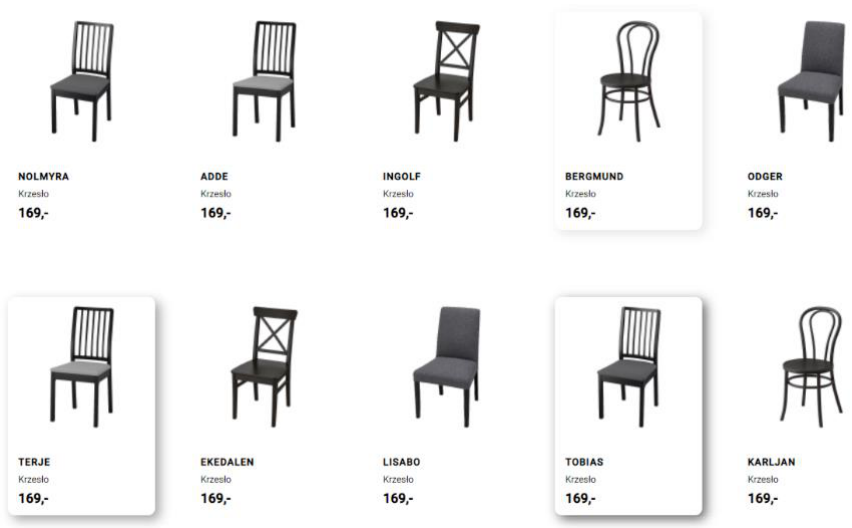
Figure 3. Sample products with different intensities of shadow. Source: own elaboration. Various types of borders and animations in one product category were also